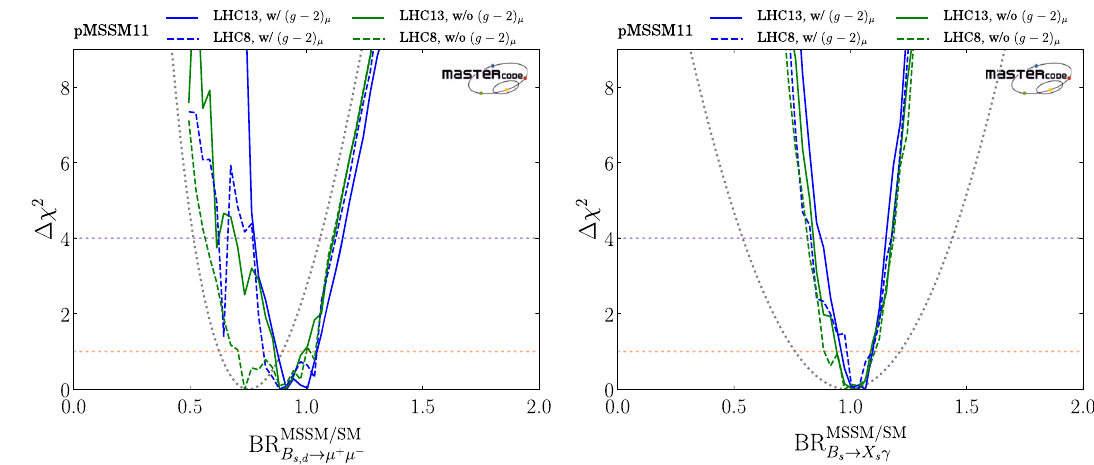
( g − 2 ) μ constraint. Also shown as dotted lines are the experimental → X γ ) branch- constraints,includingthecorrespondingtheoreticaluncertaintieswithin s s the Standard Model